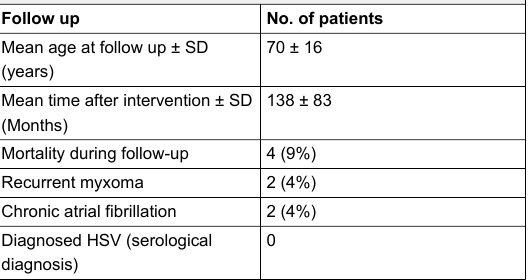
Table 4: Follow up in 46 patients after the myxoma resection. Follow